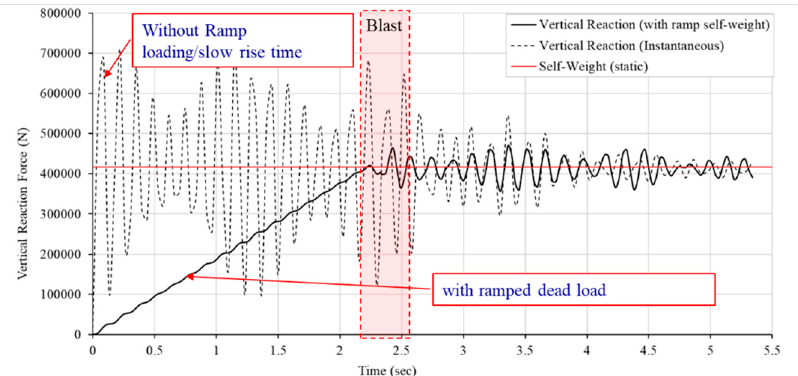
Figure 13. Vertical reaction force after ramp loading implementation in the self-weight step.